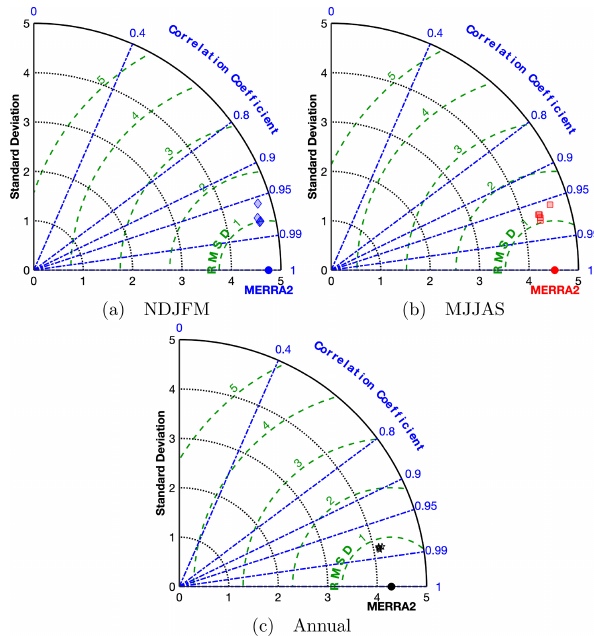
Figure 2. Taylor diagrams of AR frequency for the five-ensemble historical E3SM members against MERRA2 for the (a) NDJFM, (b) MJJAS, and (c) annual periods. The MERRA2 point is labeled in each